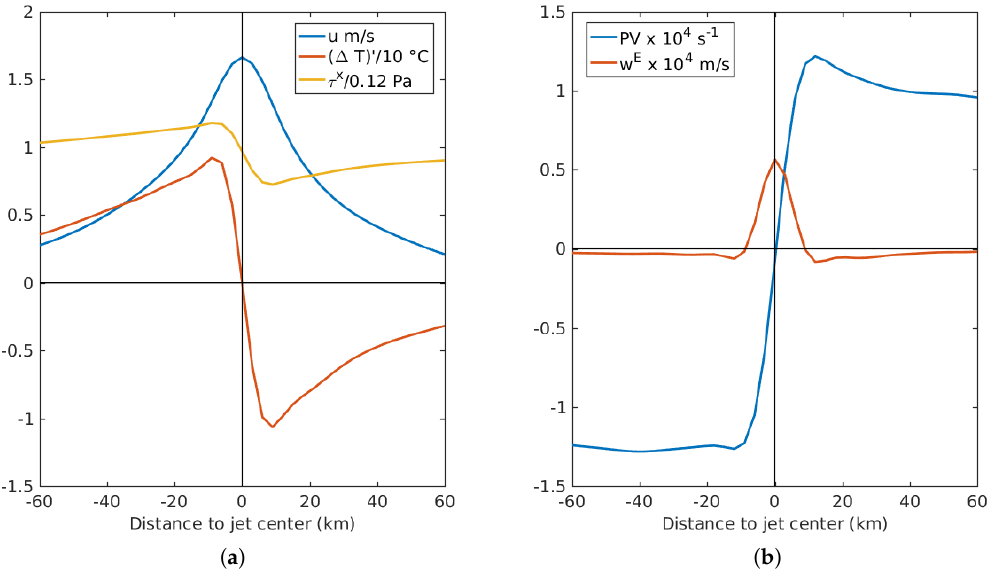
Figure 5. Time-averaged meridional profiles at 150 km east of the western boundary, centered on the instantaneous jet maximum, from a simulation with wind stress depending only on SST ( III ). ( a ) zonal velocity (m/s), high-pass filtered SST perturbation ( ∆ T ) (cid:48) (scaled by a factor of 10; ◦ C), and zonal wind stress τ x (scaled by 0.12; Pa); and ( b ) surface pseudo PV Q 1 (scaled by 10 − 4 ; s − 1 ) and Ekman pumping w E + (scaled by 10 − 4 ;